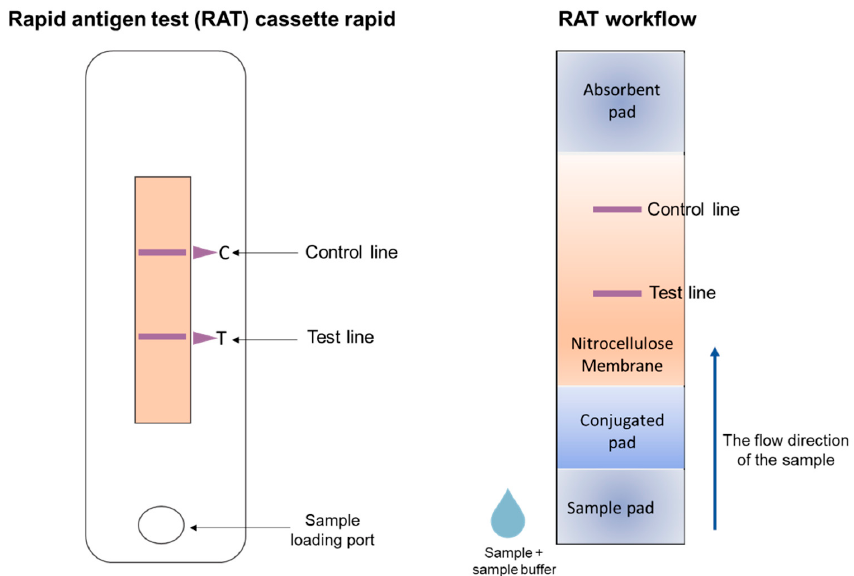
Figure 1. A schematic depicting a rapid antigen test (RAT) that adopts lateral flow immunochromatographic assay technology. The sample–buffer mixture migrates from the sample pad to the conjugated pad where the gold-labeled SARS-CoV-2 protein’s specific antibody is located to form an antibody–antigen complex. Subsequently, the complex migrates to the nitrocellulose detection membrane that contains immobilized antibodies. The lines that appear on both the C and T lines indicate a positive result. The C line must be present for a test to be considered valid.